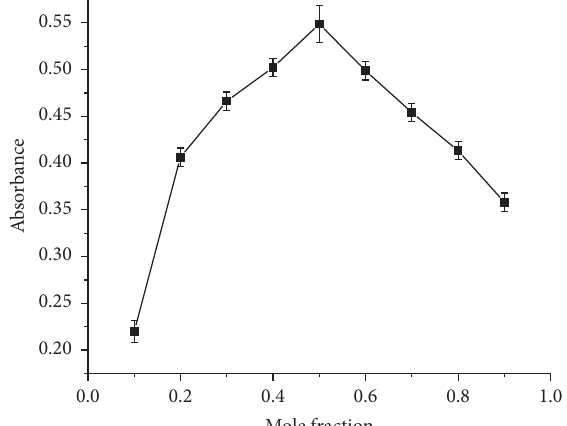
Figure 6: The graph of continuous variation method plotted as absorbance versus mole fraction of complexes of 5.0 × 10 − 5 M aluminum to